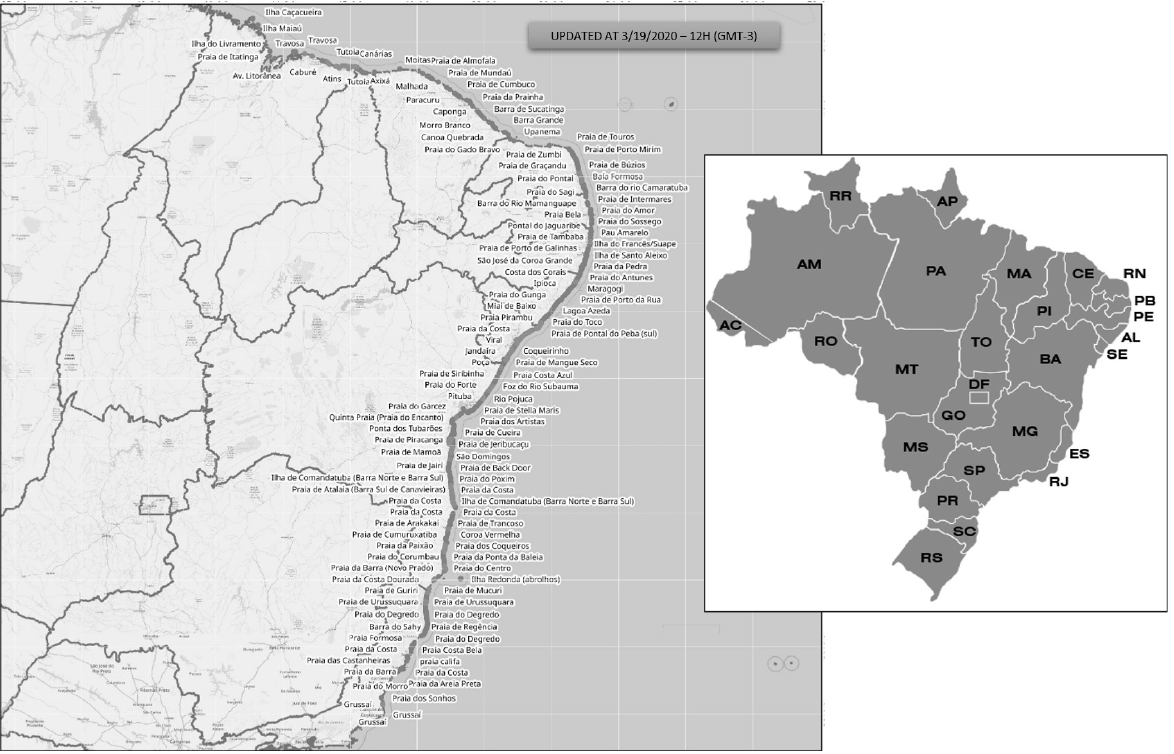
Figure 1. Geographical view of affected locations (Ibama 2019,